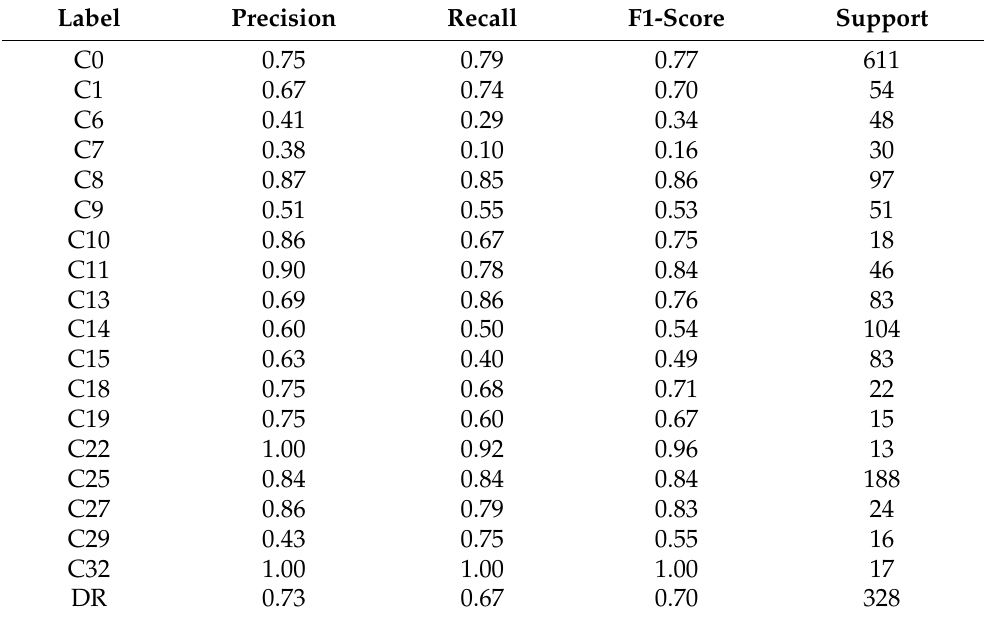
Table 4. Applying contrastive learning on the Resident dataset. The diabetic retinopathy class (DR) collects all 4 stages of the disease from classes C2, C3, C4, and